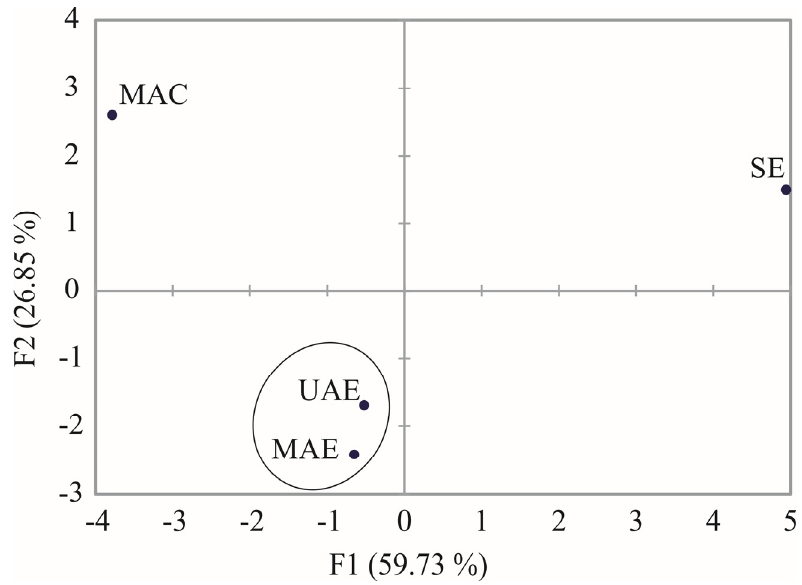
Figure 3. PCA ordination of variables based on component correlations.